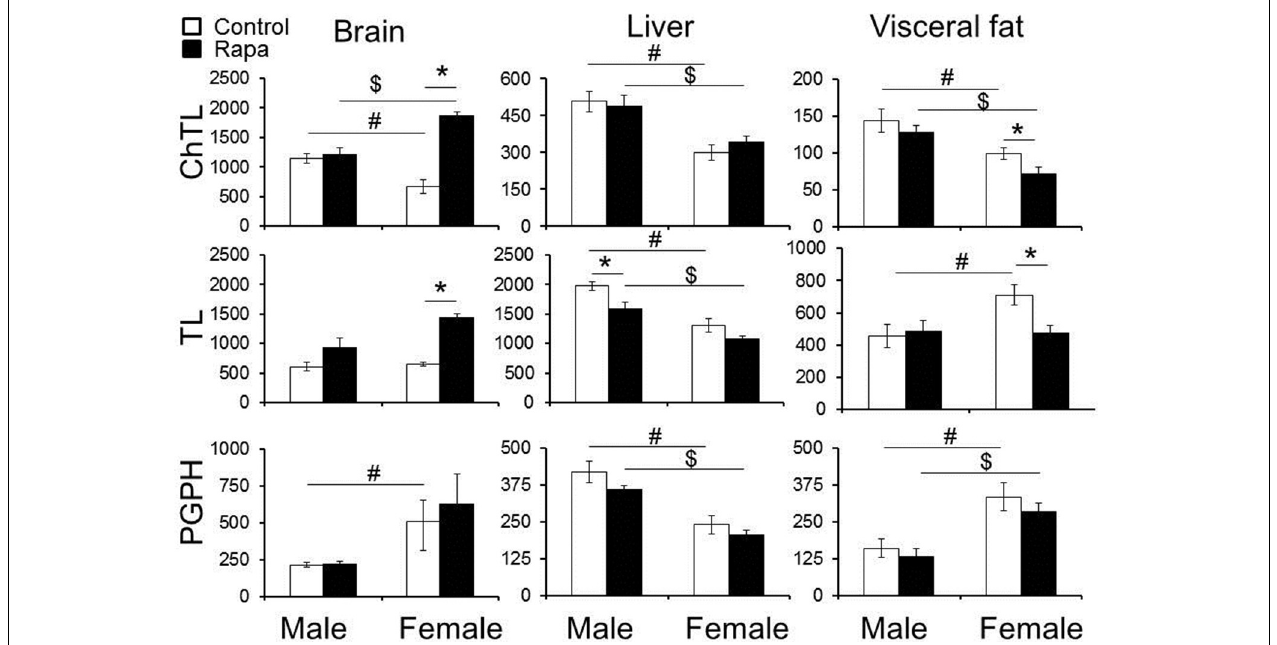
FIGURE 1 | Changes in chymotrypsin-like (ChTL) and trypsin-like (TL) 26S proteasome activity in rapamycin-treated lysates from old animals depended upon the tissue type and sex of the animals tested. Significant increase was observed for both ChTL (3X) and TL (2X) 26S proteasome activities in whole brain lysates from female animals only. No significant effects were evident in male brains. Liver TL activity declined (0.8X) with rapamycin treatment in males. Rapamycin treatment led to a decline in